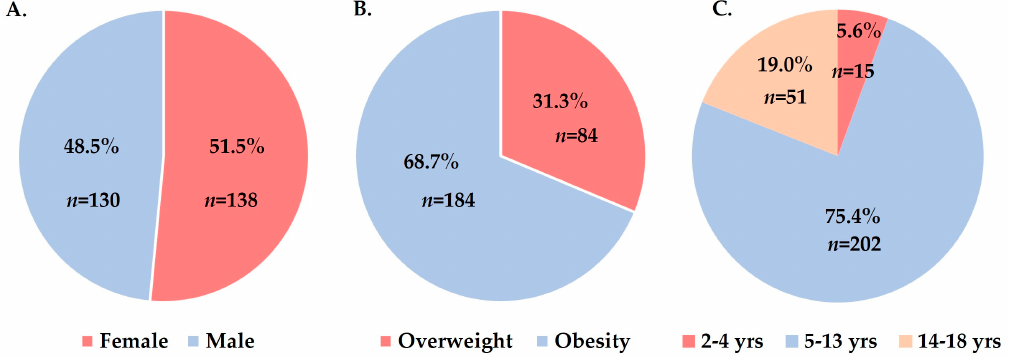
Figure 1. Distribution of children by sex ( A ), type of excess body weight ( B ), and age group ( C